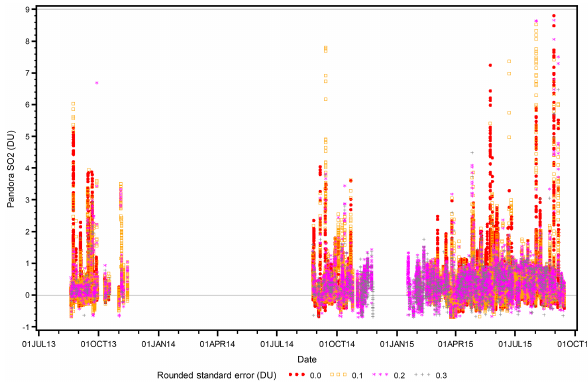
Figure 6. Time series of SO 2 measurements at Fort McKay from August 2013 to October 2015. Different symbols and colours rep- resent different standard errors estimated by the fitting algorithm. Data from December 2014–January 2015 are missing because of low sun elevation ( µ>